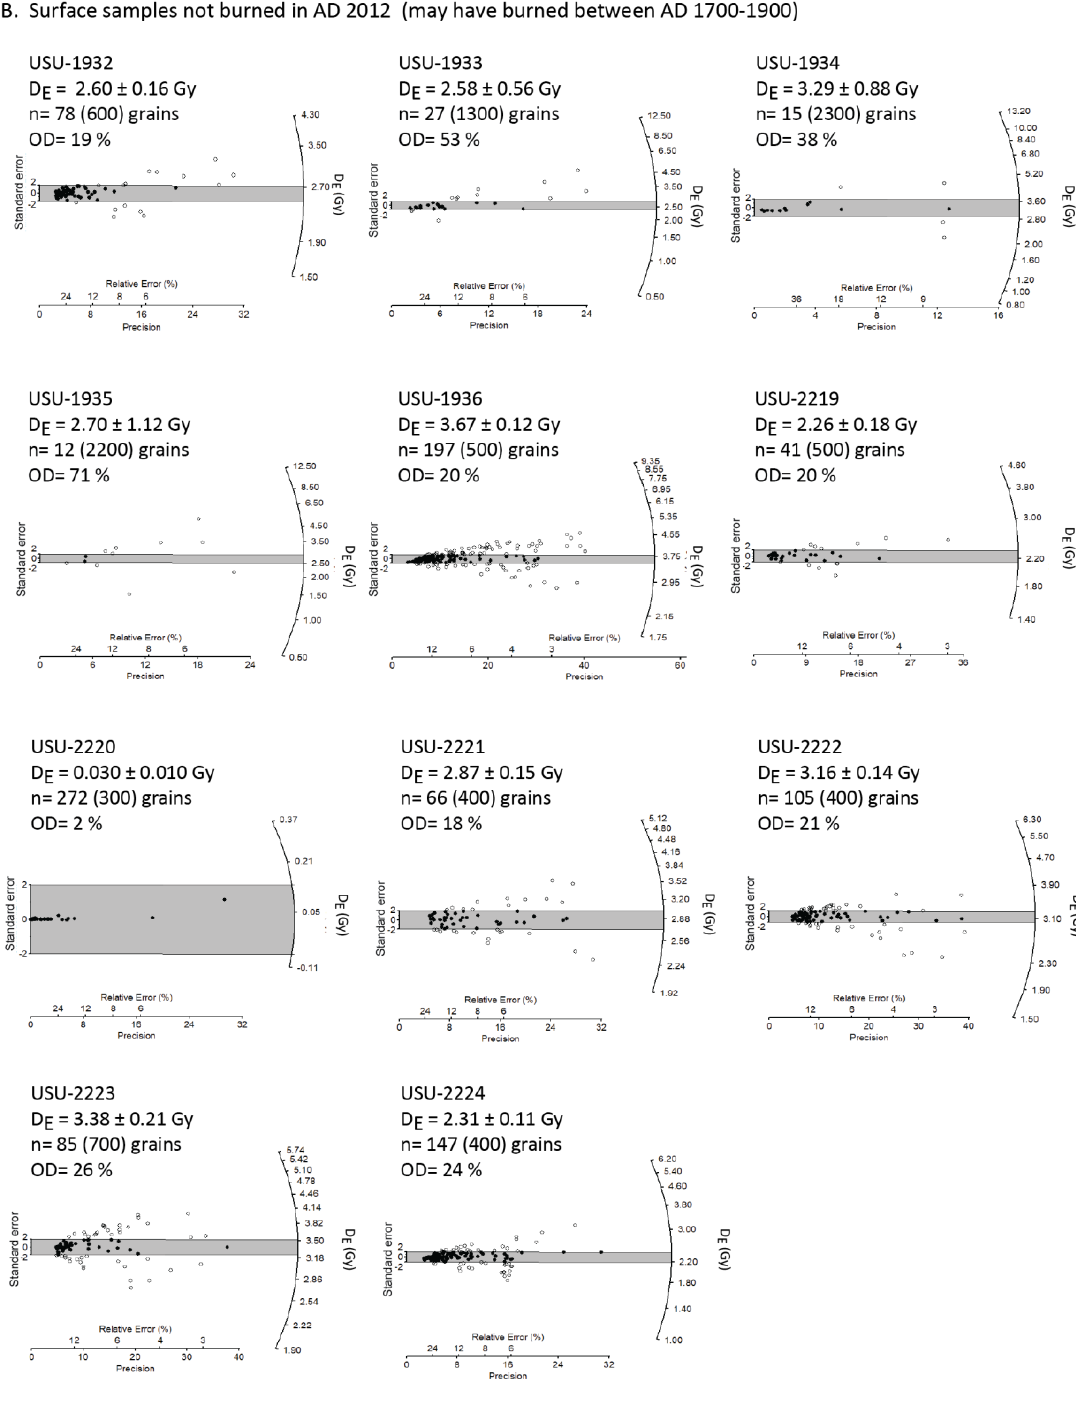
Figure A5. Radial plots of OSL measurements of ceramics that were unburned in 2012 but that could have burned between 1696 and 1893 CE.